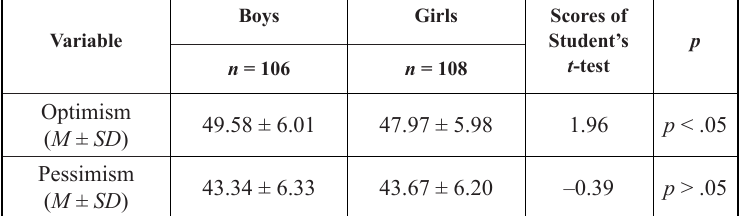
Table 3. The statistical indicators of the optimism expression among boys and girls in physical education classes ( M ± SD )